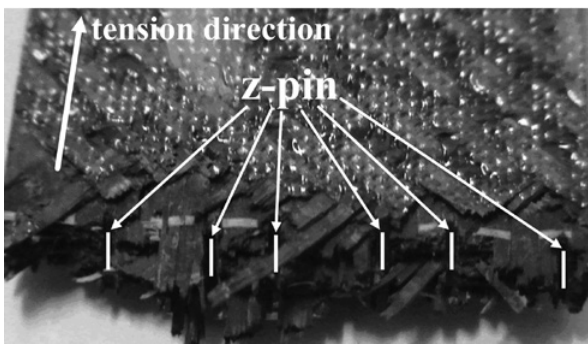
specimen with Z-pins. 2S